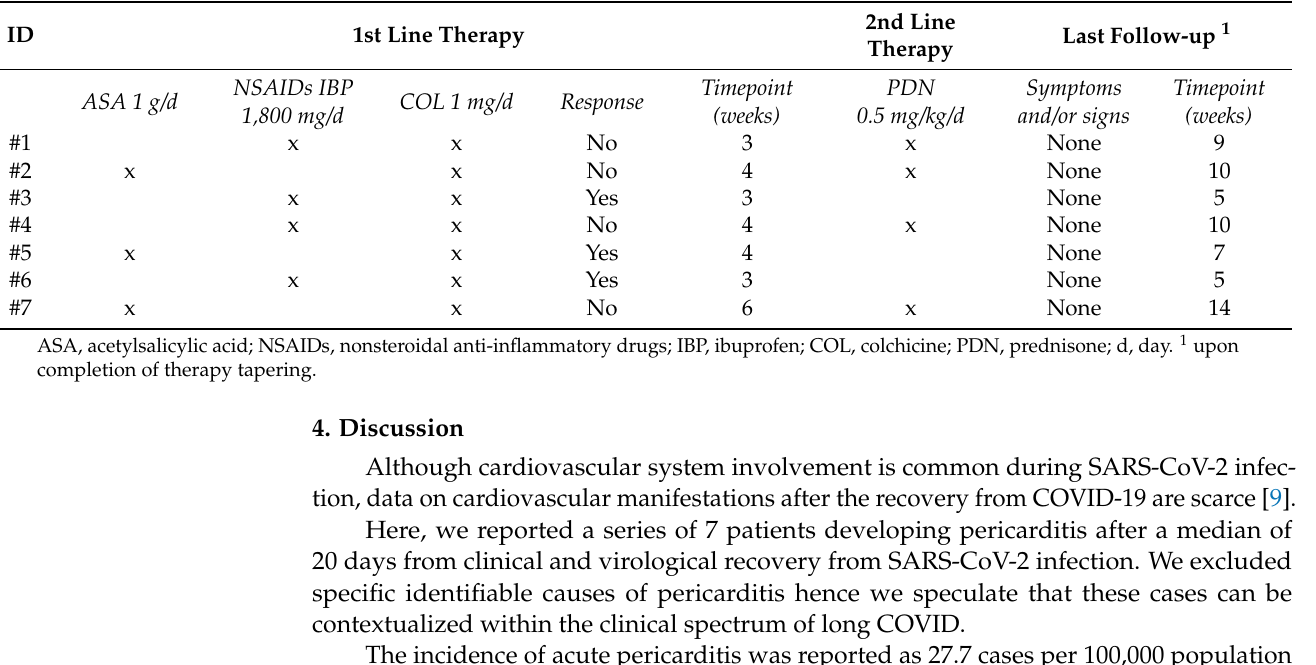
Table 3. Management and evolution of